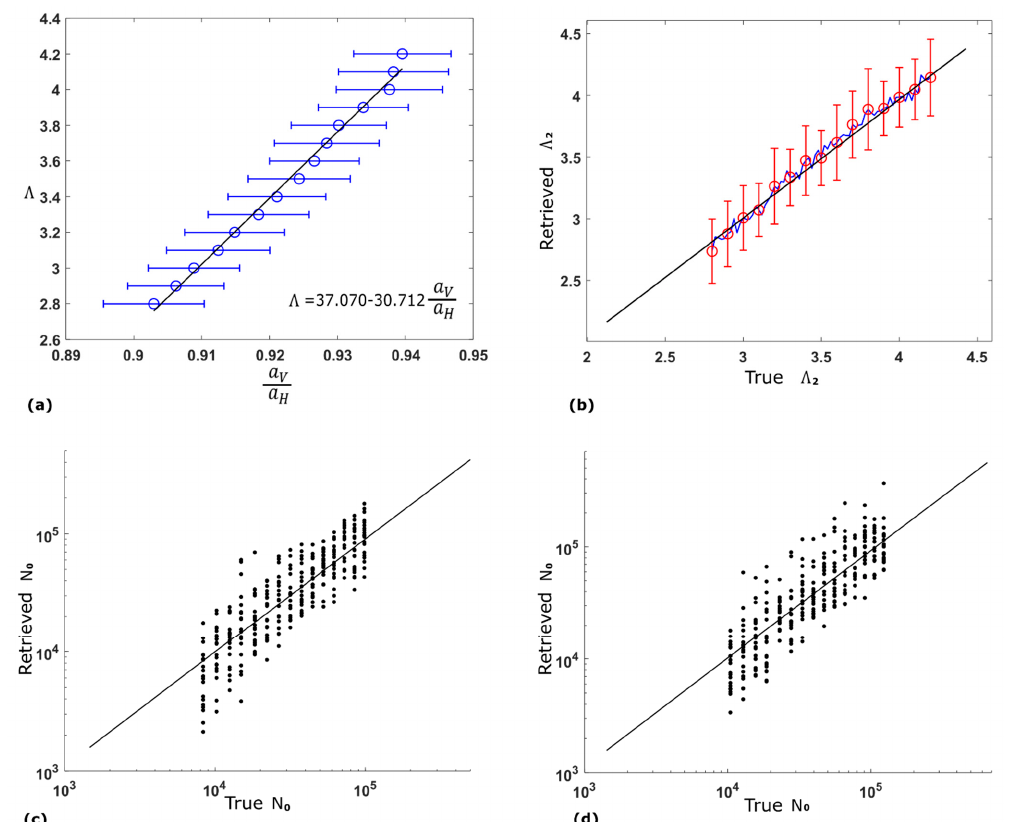
Figure 5. ( a ) The retrieved specific attenuation ratio when the slope parameter for area V takes different values. Each blue circle represents the mean for 100 simulations, and each error bar shows the standard deviation. The black line is the linear regression result over the blue circles, which is also given by the equation. ( b ) The retrieved slope parameter using the linear relationship. The blue line shows the average for 100 simulations and the red bars show the standard deviation at certain values. ( c ) Scatter plot of the retrieved intercept parameter for voxel A. ( d ) Scatter plot of the retrieved intercept parameter for voxel